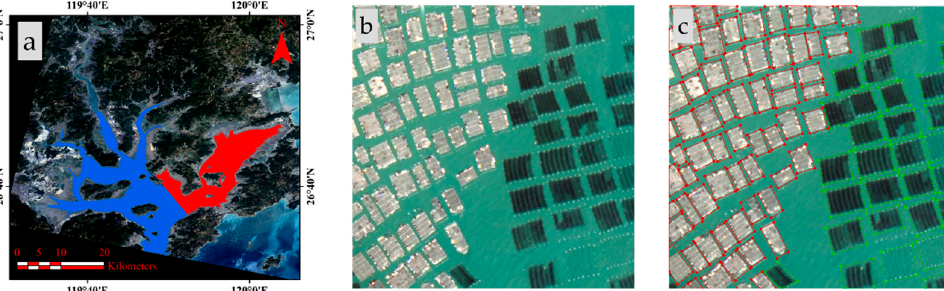
Figure 7. Dataset division of Sansha Bay ( a ), where the blue patch represents the range of the training set, and the red patch represents the range of the test set; an example image in the training dataset with a repulsion of 800 × 800 pixels ( b ); building of the training set by labelme ( c ), where the red borders represent cages, and the green borders represent rafts.